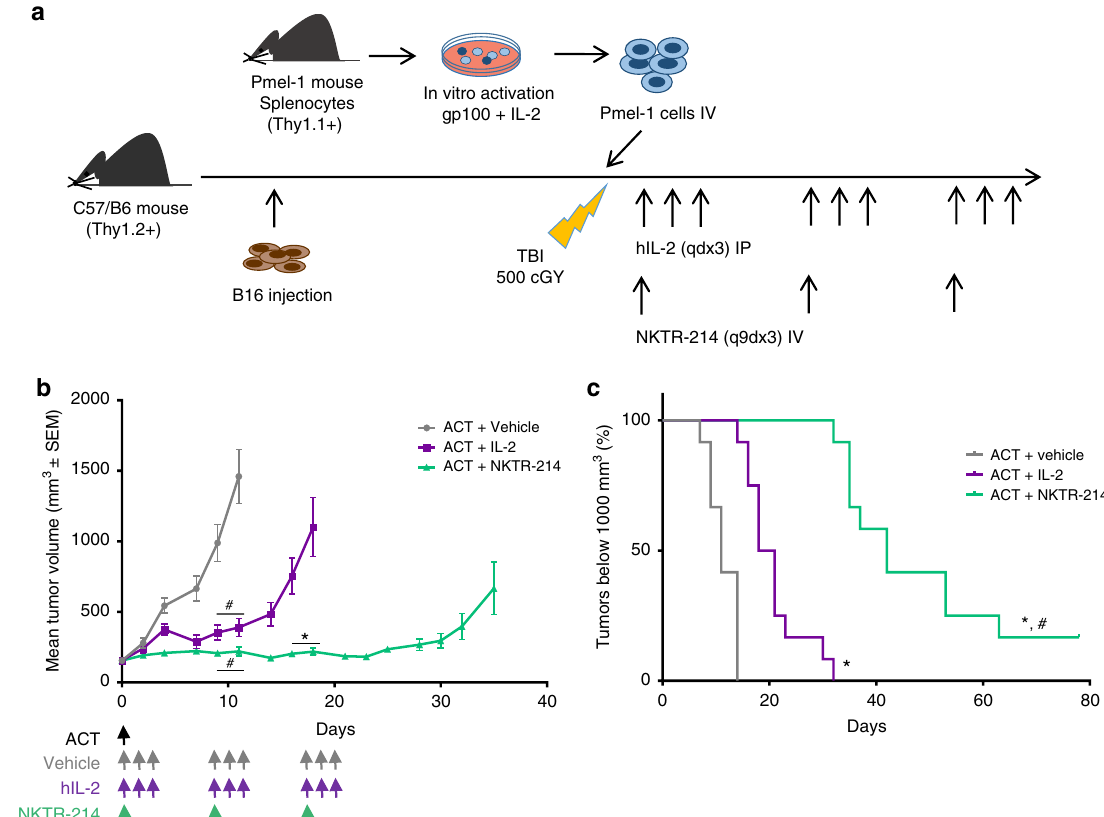
Fig. 1 Superior antitumor response by adoptively transferred T cells with NKTR-214 compared to IL-2. a Schematic of the pmel-1 ACT model. Time points in days throughout the text refer to the number of days post-administration of ACT + NKTR-214 or ACT + IL-2 at day 0. Subsequent to day 0, no further ACT was given. A second dose of either NKTR-214 (one dose) or IL-2 (qdx3) was given at day 9 and day 18 per the q9dx3 dosing regimen. b Changes in mean tumor volume over time. Data are means± s.e.m ( n = 12). * p < 0.0001 compared to ACT + IL-2; # p < 0.0001 compared to vehicle (two-way ANOVA, with Bonferroni-Dunn multiple comparisons test). ( c )Tumor growth delay was assessed for each tumor growth curve by interpolating the time to achieve tumor volume of 1000 mm 3 . # p < 0.0001 compared to ACT + IL-2 (Log-Rank Mantel – Cox test). The experiment is representative of three